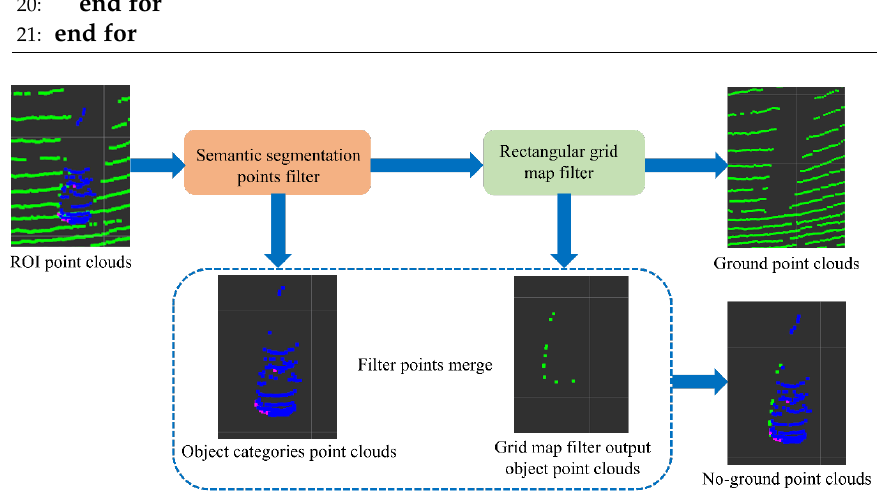
Figure 6. The pipeline of ground